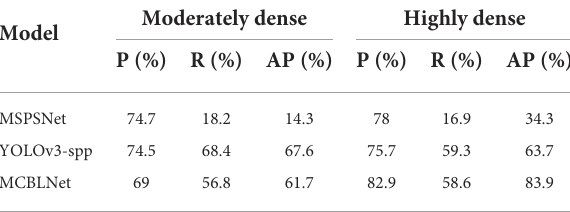
TABLE 2 Localization results of three methods under different density distributions.